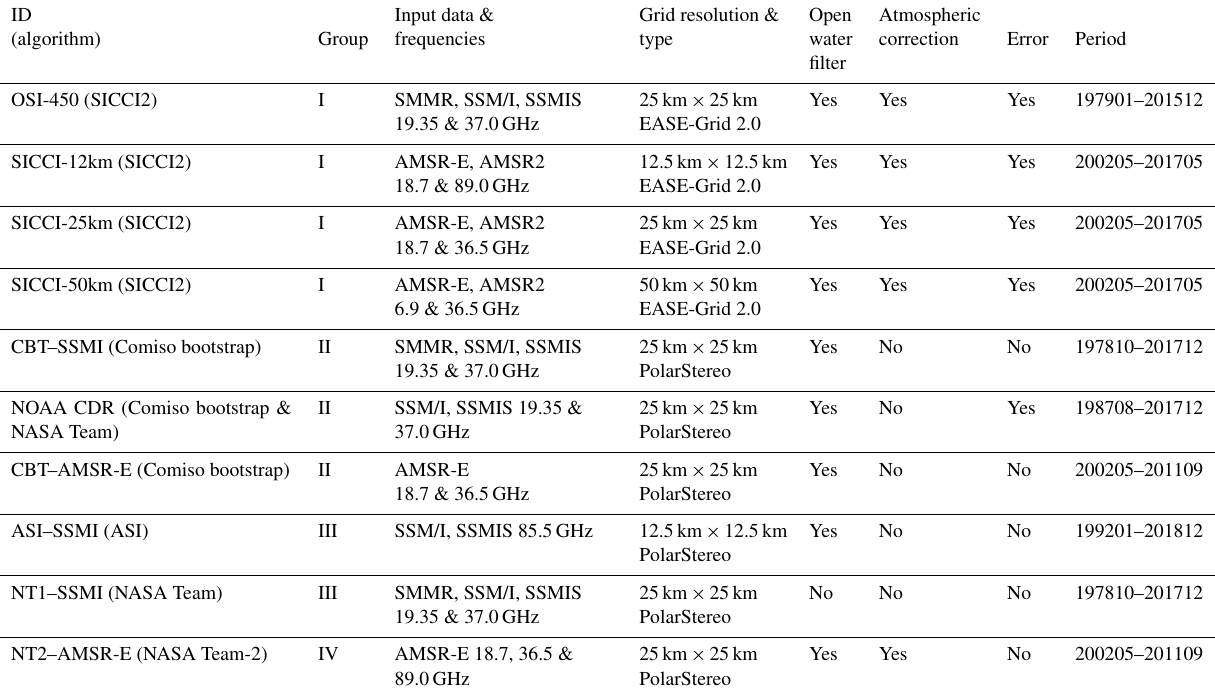
Table 2. Overview of the investigated sea-ice concentration products. The column “ID (algorithm)” holds the identifier we use henceforth to refer to the data record and which algorithm it uses. Group is an identifier for the retrieval concept used. The column “Input data” refers to the input satellite data for the data set. The column “Open water filter” refers to whether weather-related spurious sea-ice concentrations in open water and low-concentration areas are filtered. Weather filters do not remove weather-related noise over areas with near-100% sea-ice concentrations. The column “Atmospheric correction” refers to correcting the input TBs for a potential inherent weather influence using additional independent weather information. The column “Error” refers to the provision of sea-ice concentration uncertainties, and “Period” is the time period for which we use the data set, given as